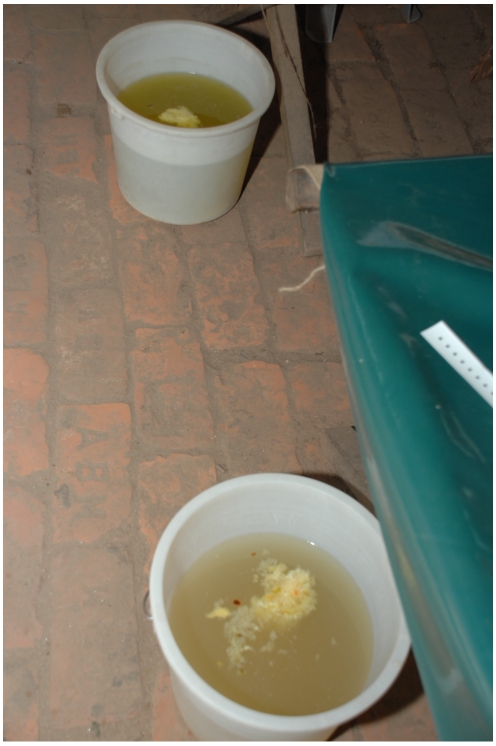
The patient's stool.